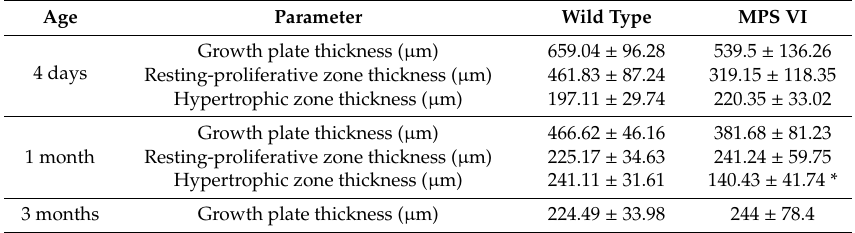
Table 1. Histomorphological measurements of wild type and mucopolysaccharidosis type VI (MPS VI) growth